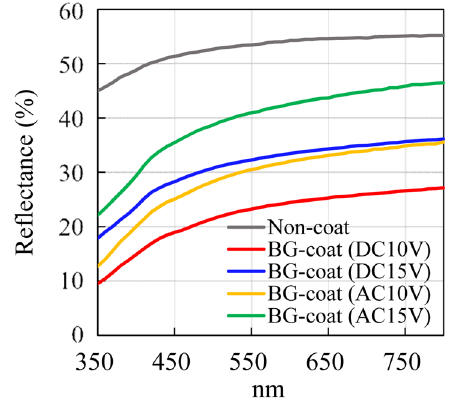
Figure 2. Diffuse reflectance curves of the various specimens. Table 1. Commission International de L’clairage (CJE) lightness ( L *) and color ( a *, b *) values for the specimens.